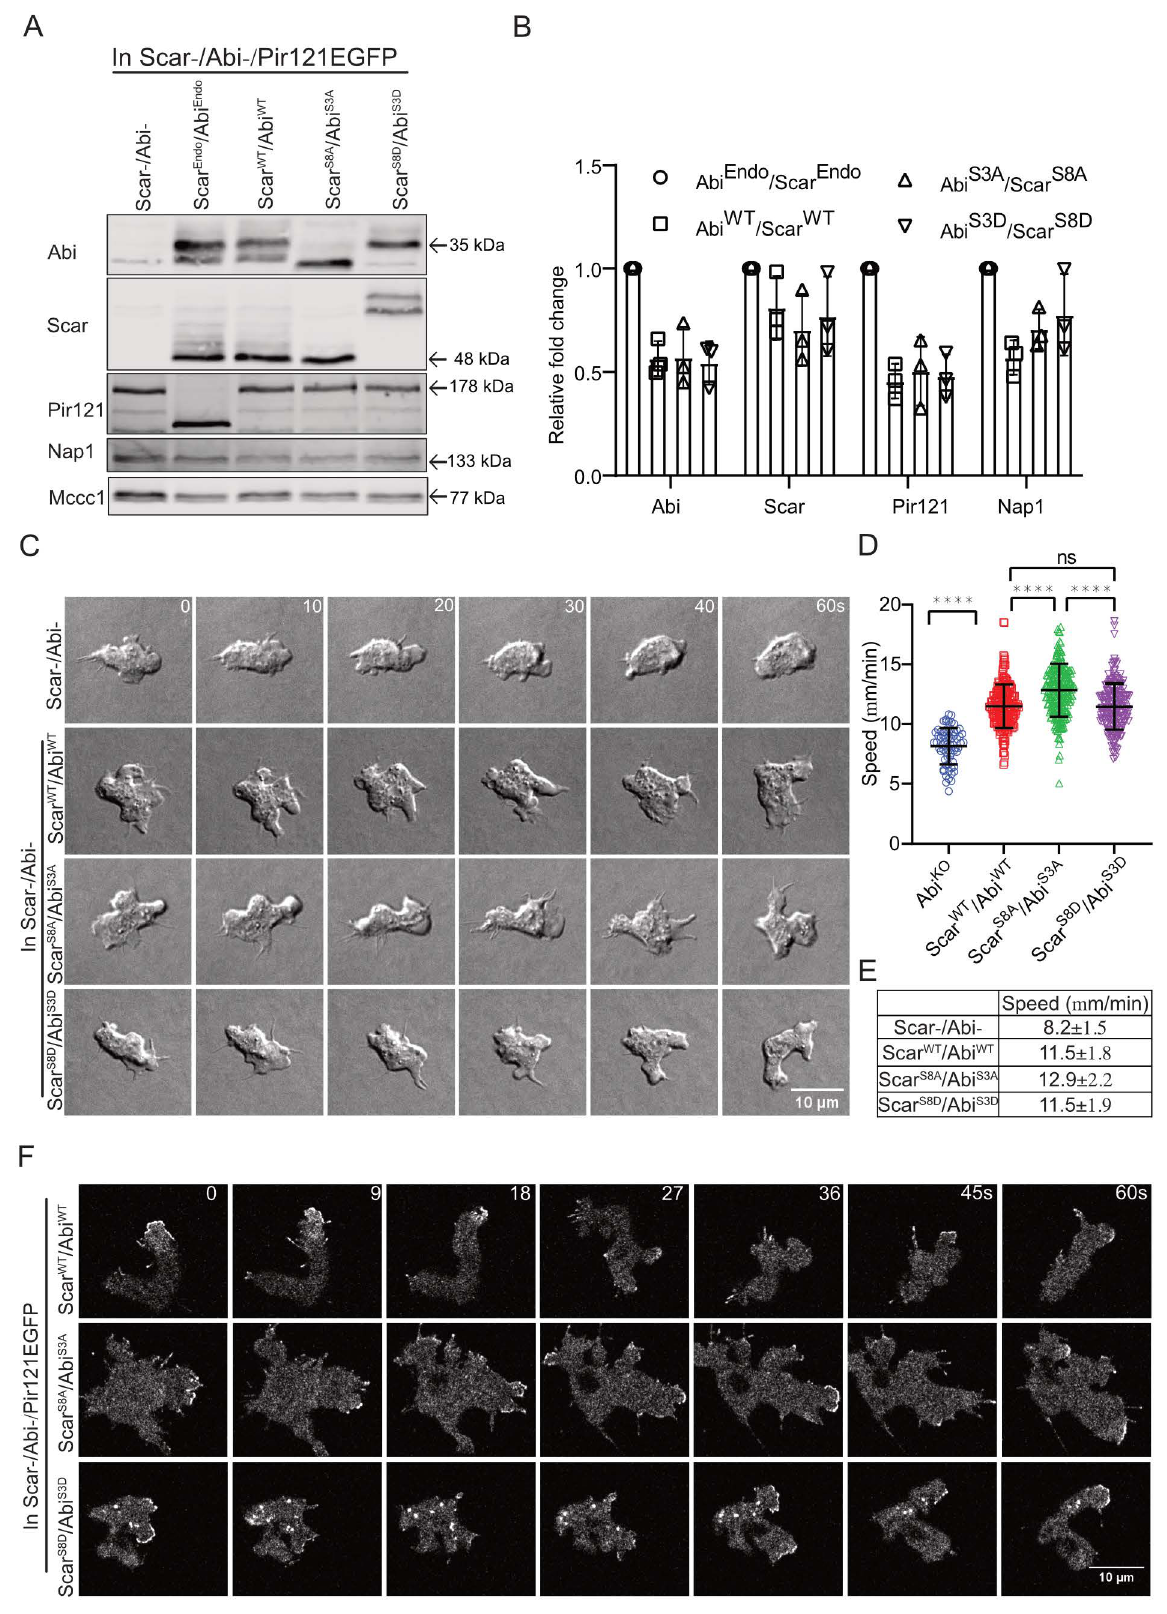
Figure 6. Both Scar and Abi phospho-mutants are recruited to pseudopodia and are functional. ( A ) Stability of the WT and phosphomutant Scar/WAVE complex. Scar WT /Abi WT , Scar S8A /Abi S3A and Scar S8D /Abi S3D were expressed in Scar-/Abi-/Pir121-eGFP cells. Expression of Abi, Scar, Pir121 and Nap1 was compared by Western blotting. WT and